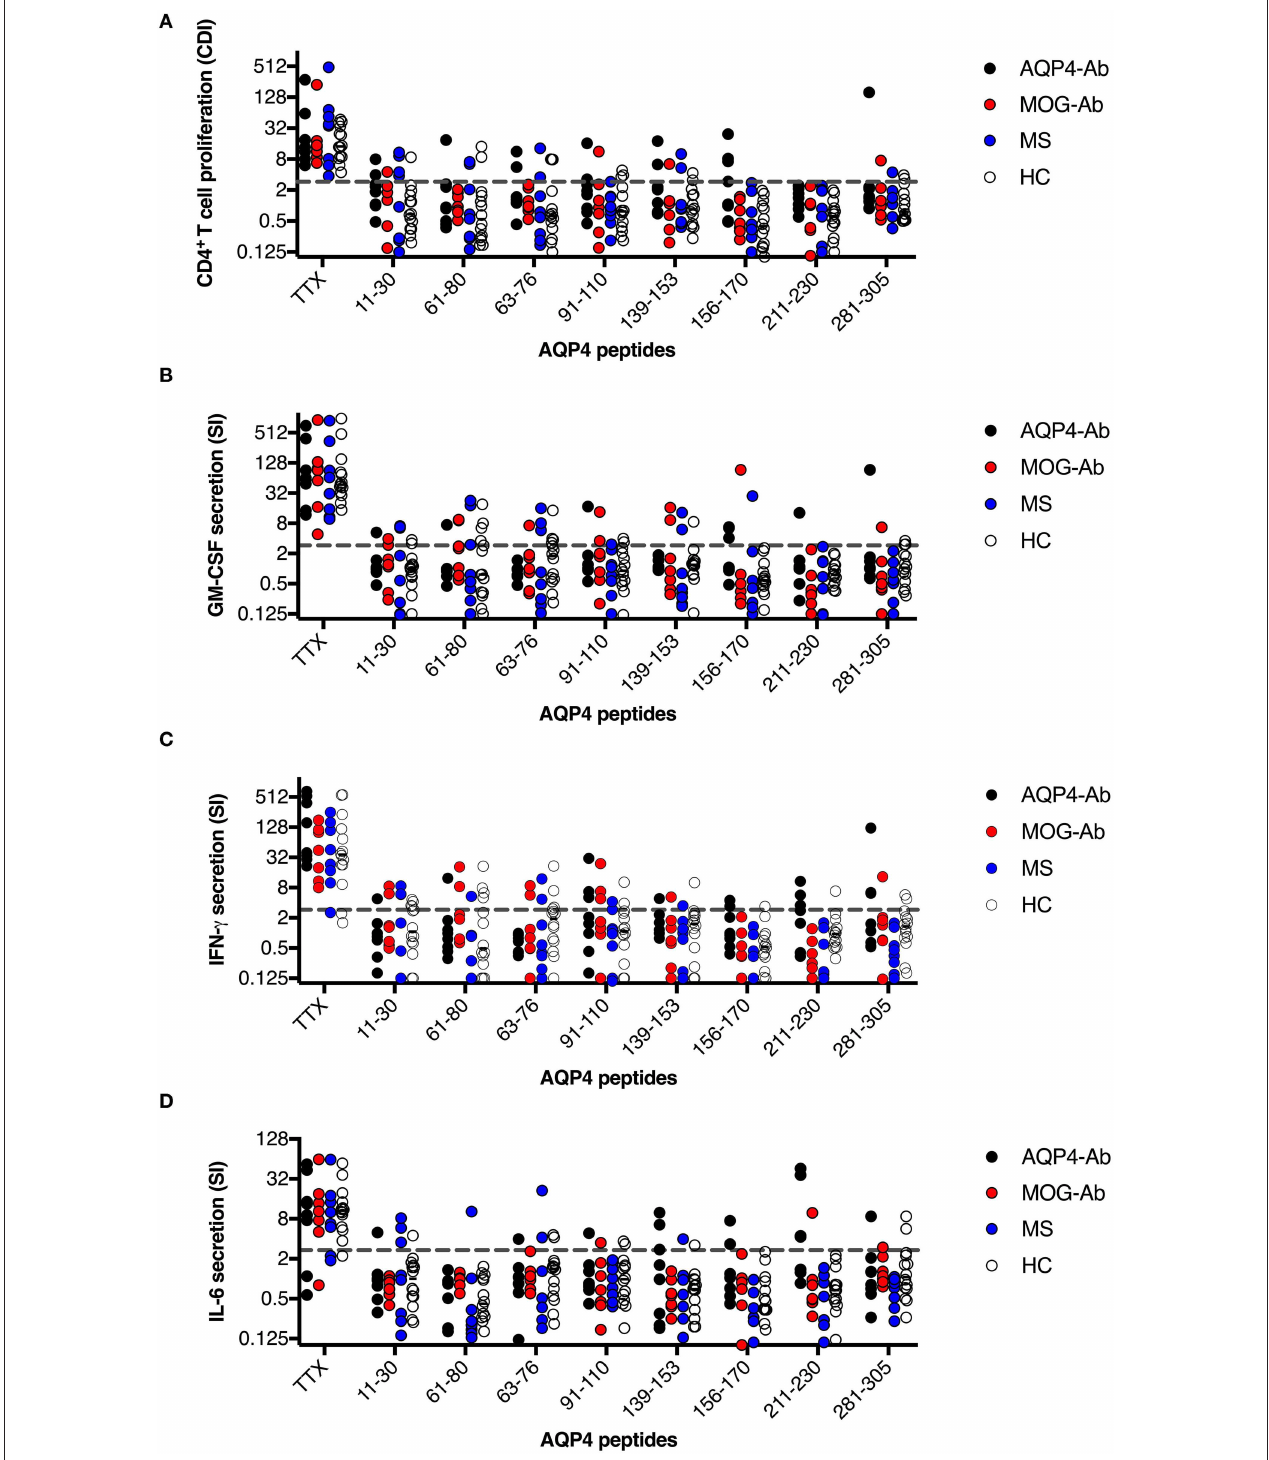
FIGURE 3 | CD4 + T-cell reactivity to AQP4 peptides in participants with AQP4-Ab ( n = 8), MOG-Ab ( n = 7), MS ( n = 8) and HC ( n = 14). (A) CD4 + T-cell proliferation after challenging with respective AQP4 peptides and the positive control TTX. The cut-off value of a CDI ≥ 3 is indicated by a gray dashed line. Secretion of GM-CSF (B) , IFN- γ (C) and IL-6 (D) after challenging with respective AQP4 peptides and the positive control TTX. The cut-off SI ≥ 3 is indicated by a gray dashed line. AQP4-Ab, aquaporin-4 antibody positive; CDI, cell division index; GM-CSF, granulocyte-macrophage-colony-stimulating factor; HC, healthy controls; IFN, interferon; IL, interleukin; MOG-Ab, myelin oligodendrocyte glycoprotein antibody positive; MS, multiple sclerosis; SI, stimulation index; TTX, tetanus toxoid.